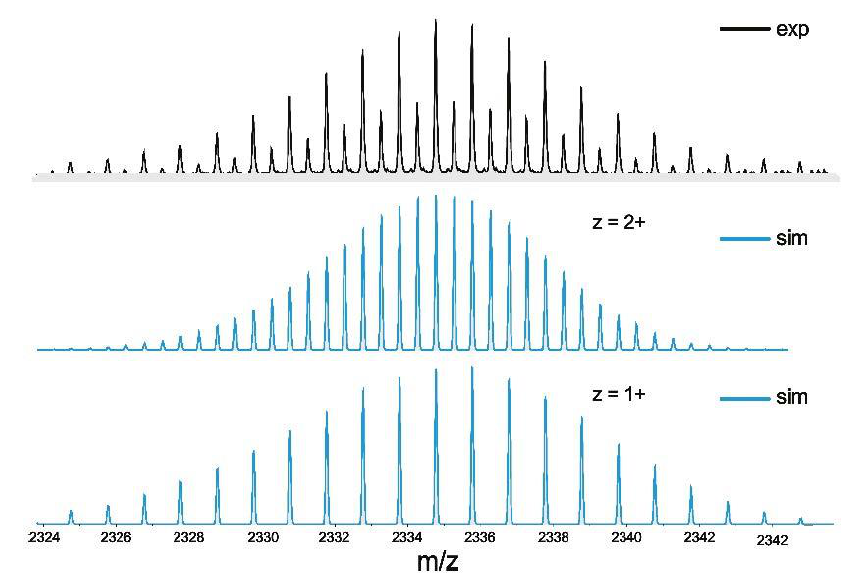
Figure 3. High-resolution ESI mass spectrum of the initial product mixture of tetranuclear 2 Ru 2 Ph- Croc and octanuclear 4 Ru 2 Ph-Croc obtained from the reaction of Ru 2 Ph-Cl with potassium croco- nate ( top ). Simulated spectrum of 4 Ru 2 Ph-Croc 2+ ( middle ) and of 2 Ru 2 Ph-Croc + (bottom ).